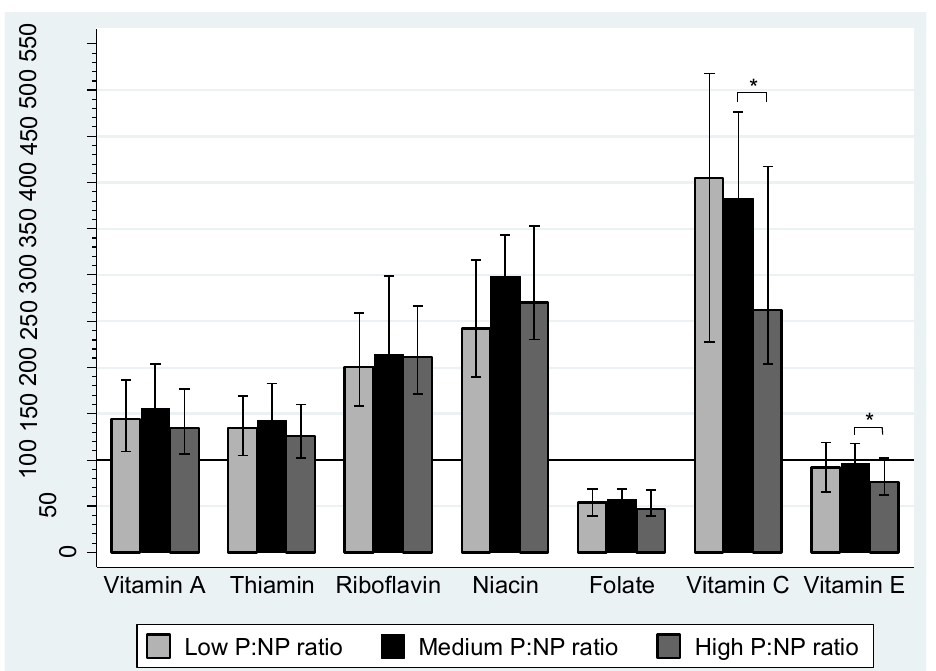
Figure 1. The percentage of Australian Nutrient Reference Value (NRV) recommendations for vitamins that were achieved during pregnancy by women in the WATCH Study who reported plausible dietary data ( n = 149) by tertile of the protein to non-protein (P:NP) ratio. Plausible data is defined as energy intakes ≥4.5 and ≤20.0 MJ/day. The proportion of protein (%E) to carbohydrate (%E) and fat (%E) was used to create P:NP tertiles. The P:NP ratio for each tertile: Low P:NP ratio group 0.21 (0.19, 0.22), n = 50; Medium P:NP ratio group 0.24 (0.23, 0.25), n = 50; high P:NP ratio group 0.28 (0.27, 0.30), n = 49. Nutrient Reference Values recommended for pregnancy: Vitamin A = 550 μg, Thiamine = 1.2 mg, Riboflavin = 1.2 mg, Niacin = 14 mg NE, Folate = 520 μg, Vitamin C = 40 mg, Vitamin E = 7 mg [30]. * P <